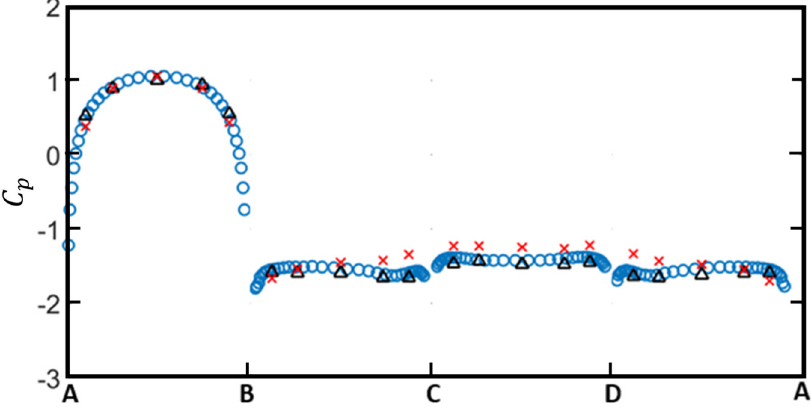
Figure 8. Distributions and comparison with previous studies of the time-averaged pressure coeffi- cient on the cylinder surfaces for α = 0°. : Present study, Re = 1000; : Norberg [35], Re = 5000; : Sohankar et al. [16], Re = 500.